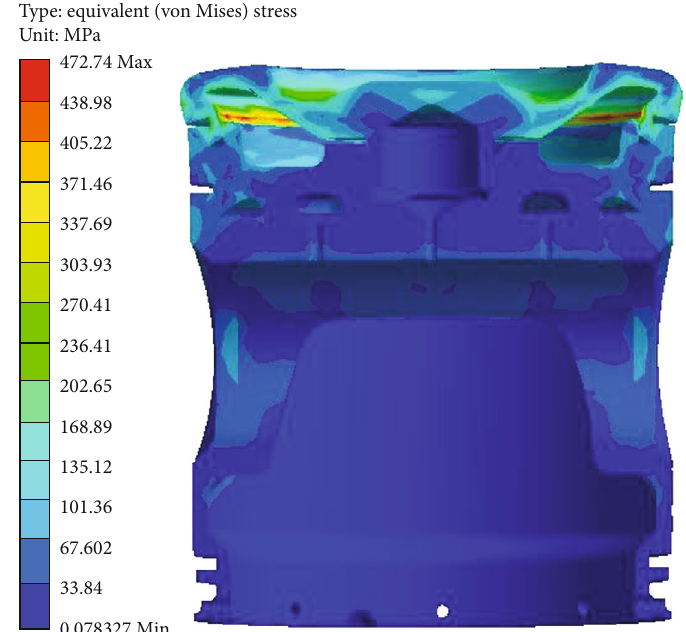
Figure 15: The von Mises stress nephogram of the piston under the new scheme condition.